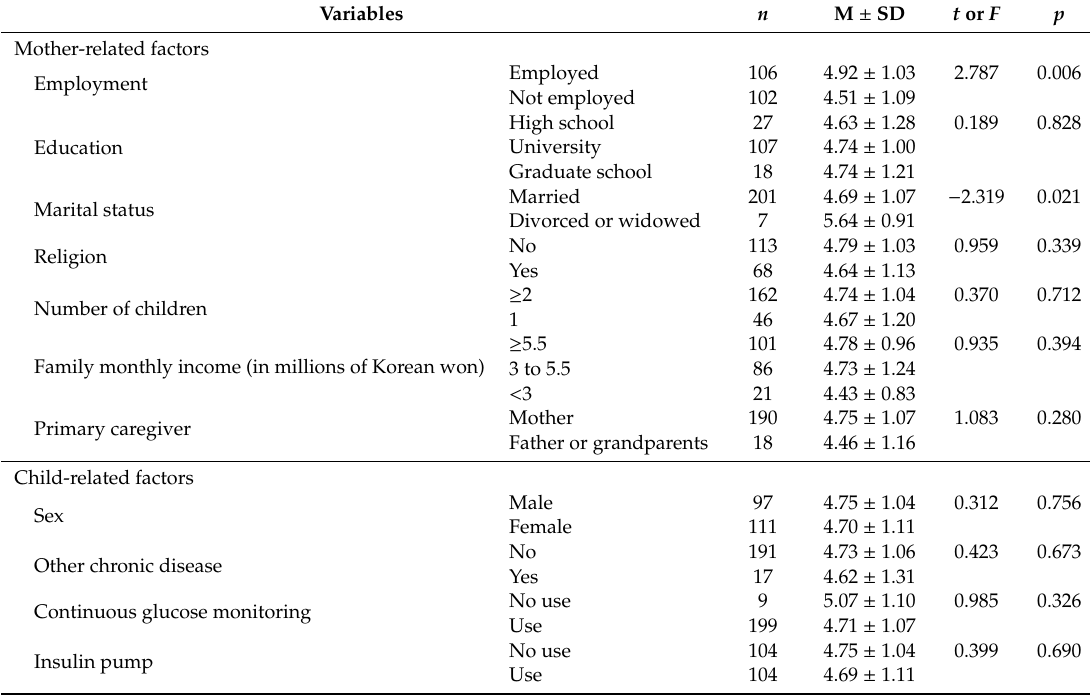
Table 2. Di ff erences in quality of life (QOL) according to demographic characteristics ( N = 208). Variables n M ±